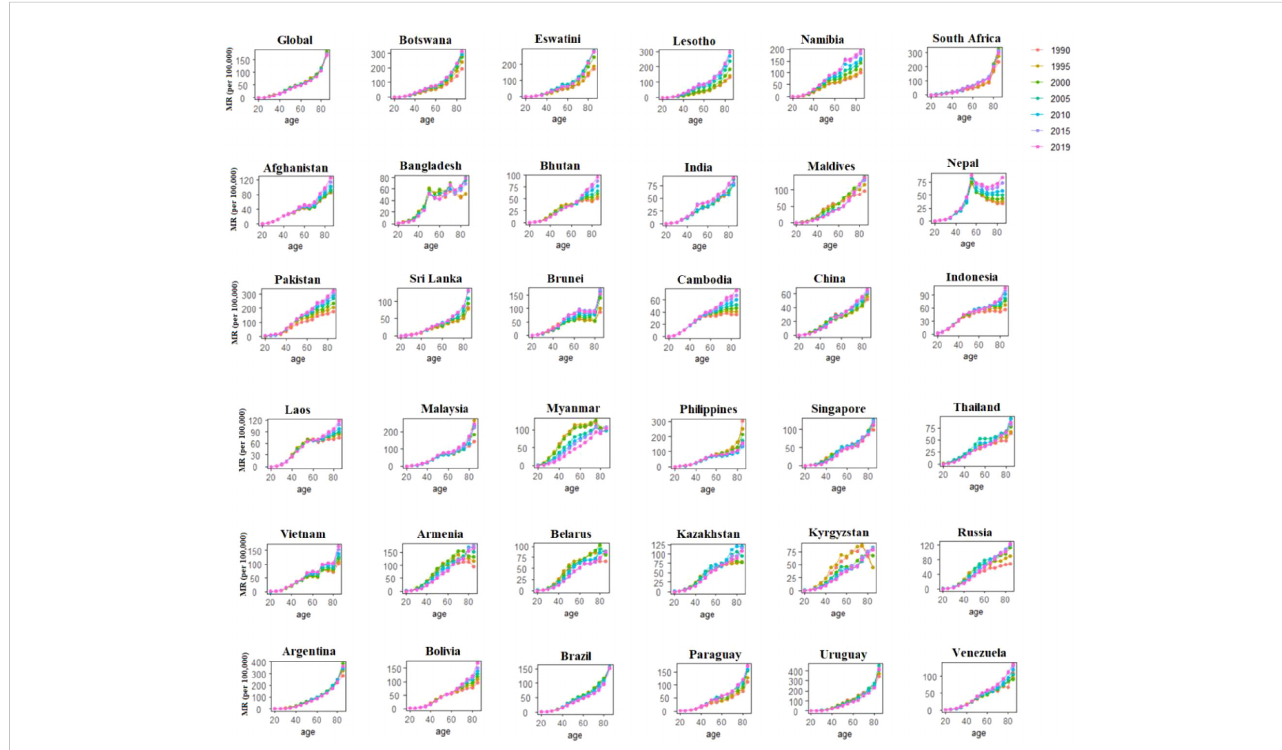
FIGURE 3 Age-speci fi c mortality rates of breast cancer by period across 35 BRICS-Plus countries and Globally between 1990 to